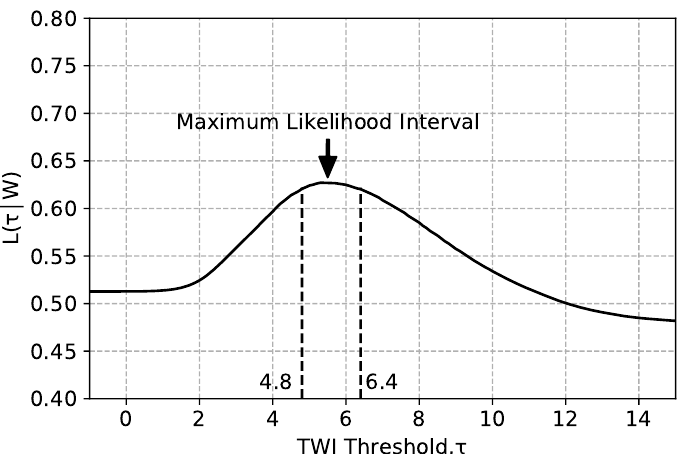
Figure 6. Likelihood function L ( τ / W ) for a 100 mm precipitation depth (case study 1).